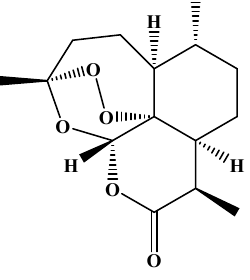
Figure 1. Artemisinin structure.